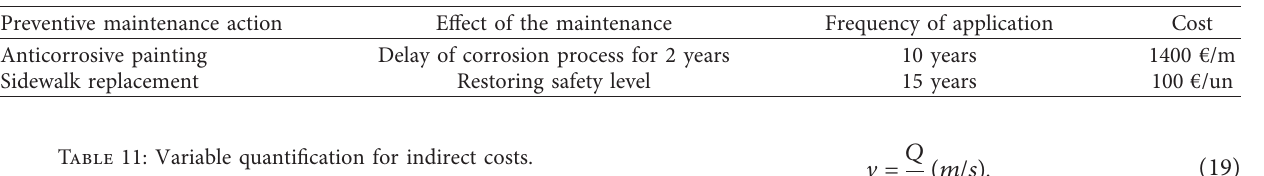
Table 10: Effects for the maintenance actions.